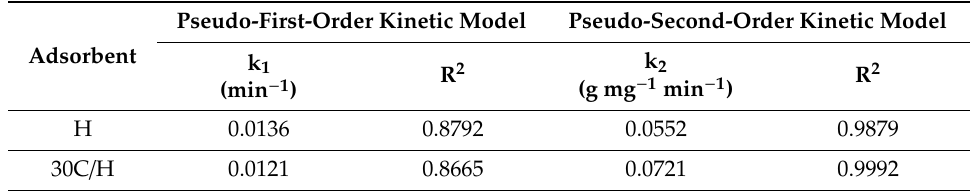
Table 5. Kinetic parameters of paracetamol adsorption on H and 30C / H adsorbents.